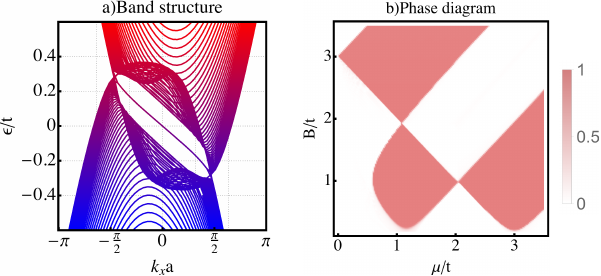
Figure 2: a) The band structure for a zigzag ribbon of W = 86 a , with in-plane field for µ = 2.9 t , B = 0.5 t , α = 0.5 t , ∆ = 0.2 t . Note the formation of chiral Majorana states y and the overall gapless character of the band structure. b) Topological phase diagram for a zigzag ribbon of W = 260 a as a function of µ and B for α = 0.5 t , and ∆ = 0.5 t . We plot the MP of the lowest energy state, thus a value of 1 corresponds to a topological phase (pink), while a value of 0 to the trivial one